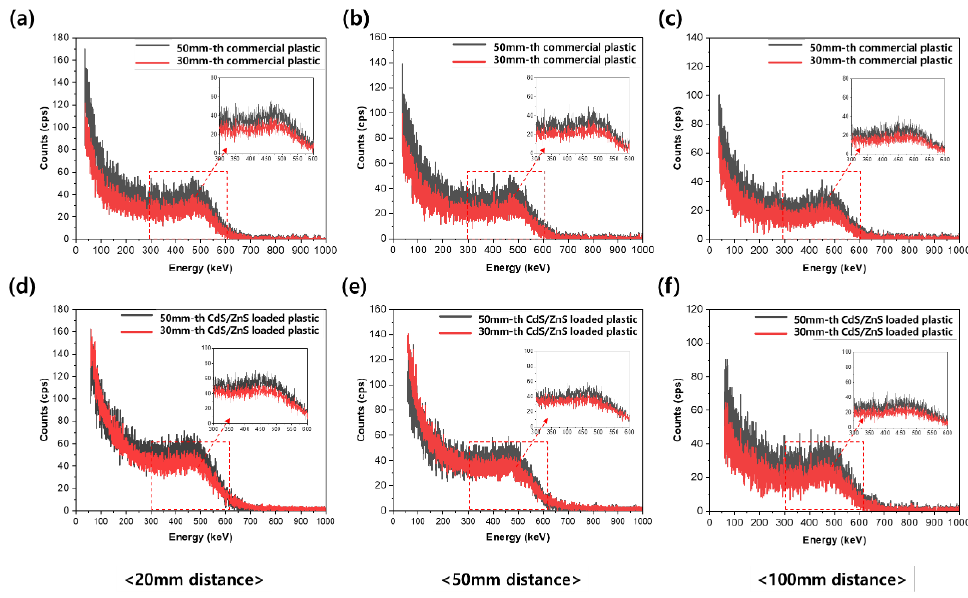
Figure 7. Measurement results using a commercial plastic scintillator ( a – c ) and CdS/ZnS-loaded plastic scintillator ( d – f ).